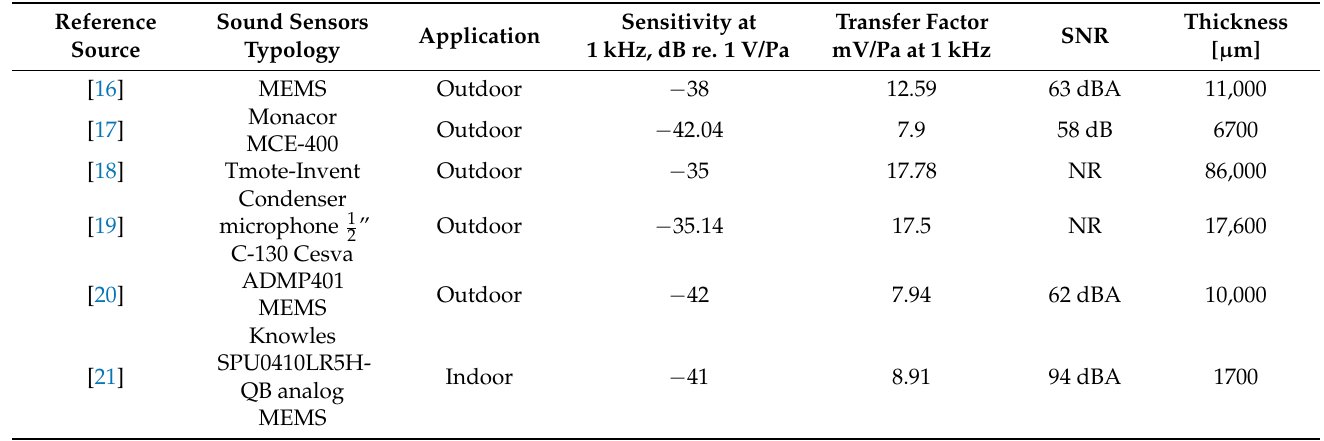
Table 3. Comparison of sound sensors typologies, thickness, and relative acoustic performances in monitoring